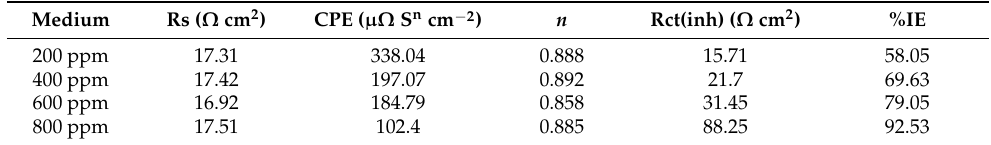
Table 5. Electrochemical impedance parameters derived from the equivalent circuit using Z-view